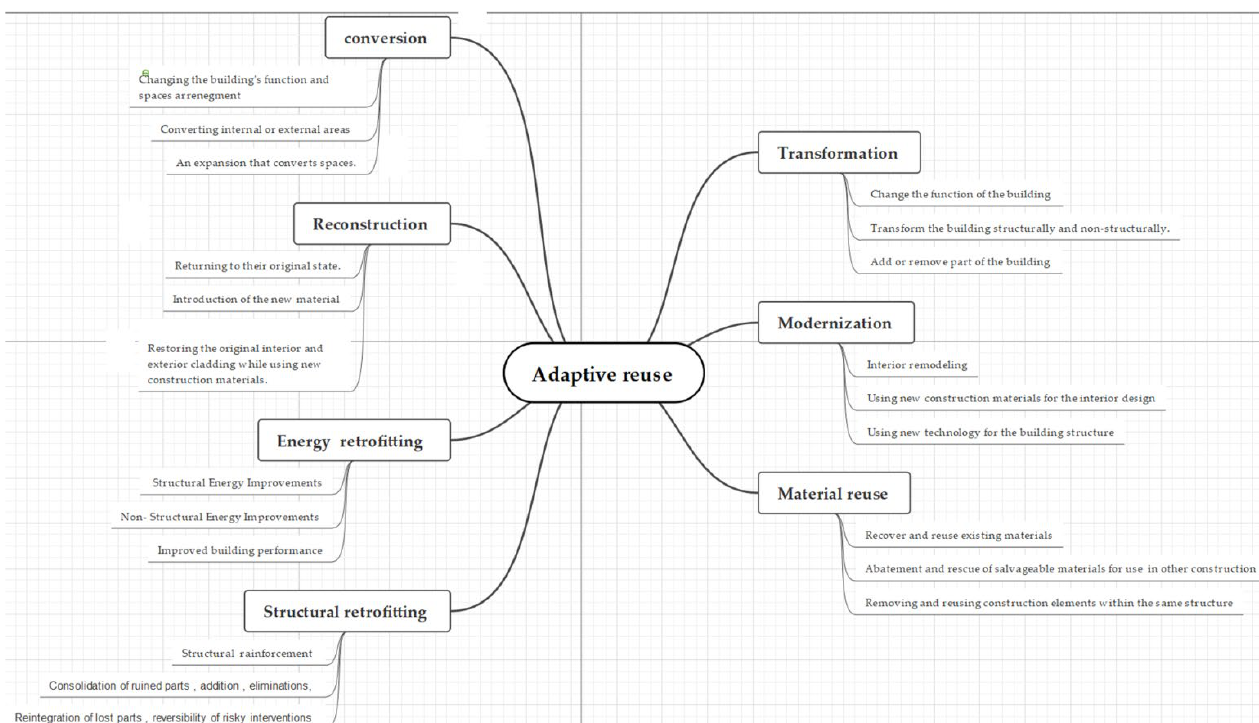
Figure 3. Functional adaptation terminologies related to adaptive reuse.